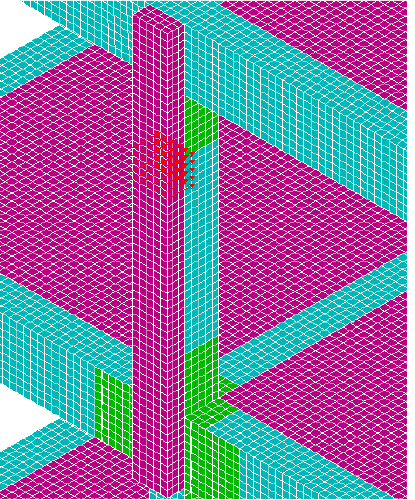
Figure 5. Finite Element Model of Structure and Load Plate Fig. 5. Finite element model of structure and load plate.